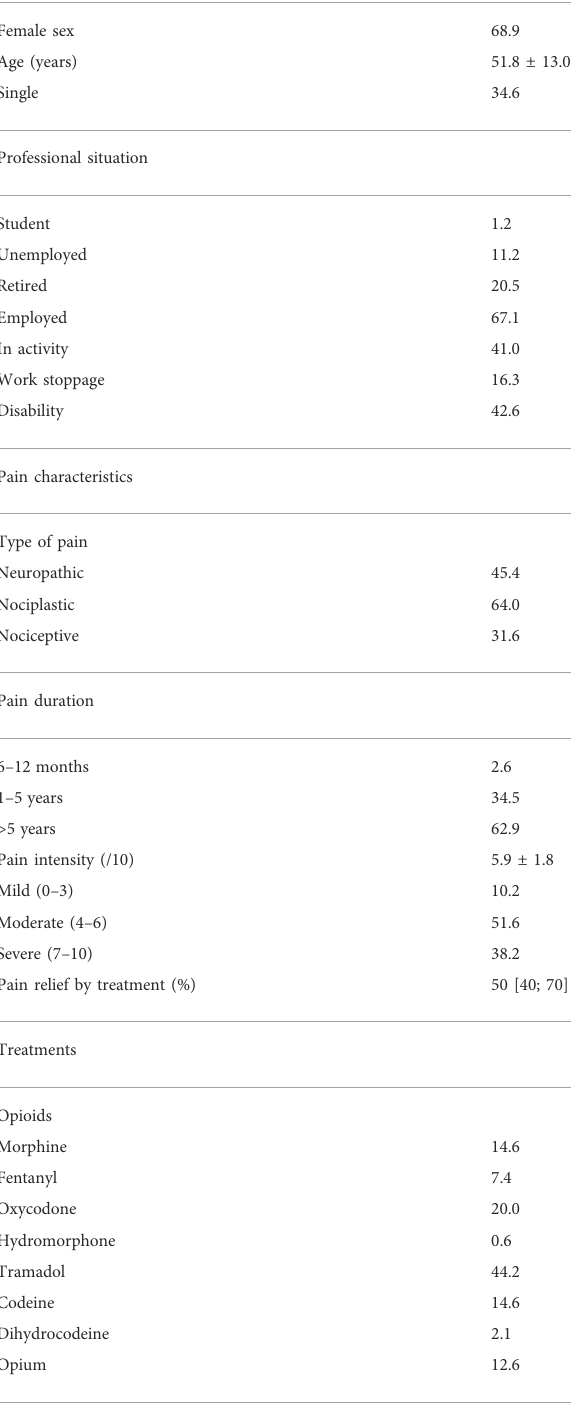
TABLE 1 ( Continued ) Study population characteristics. Data of all included patients ( n = 951) are presented as percentages, mean ± standard deviation or median (25th; 75th percentiles). * Dosage or frequency higher than